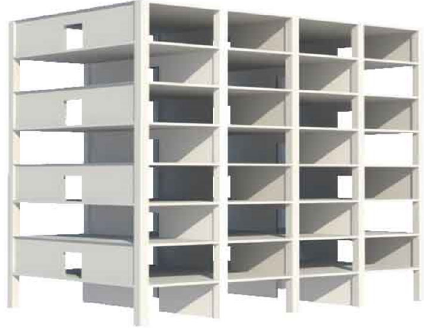
Fig. 1 Schematic view of a staggered wall structure with middle